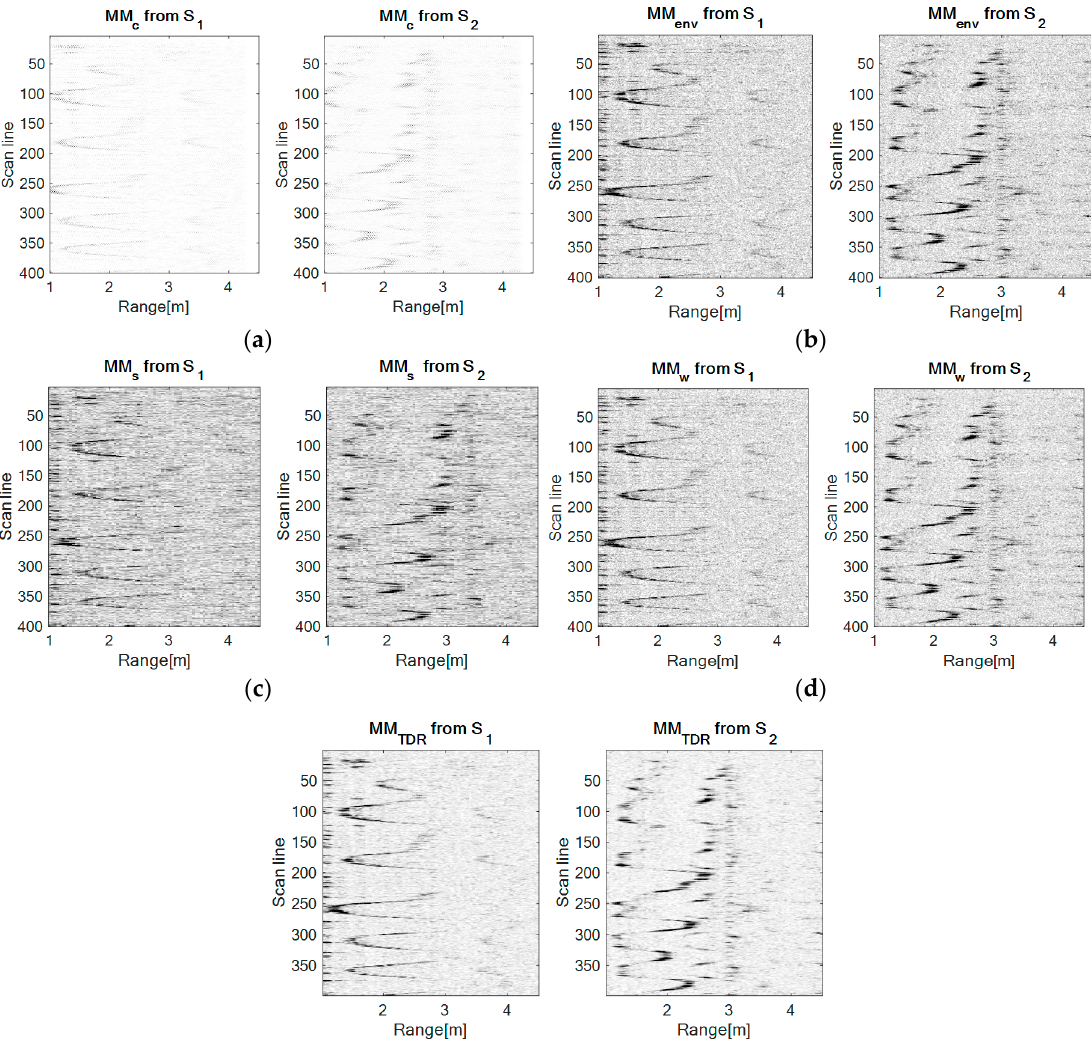
Figure 7. The movement maps for the forward-back configuration obtained with each method: ( a ) The correlation method, ( b ) the envelope detection method, ( c ) the spectrogram method: Window size: 64, number of overlapped samples: 60, number of FFT (Fast Fourier Transform) points: 128, ( d ) the wavelet transform method: Mother Morlet wavelet, ( e ) the time-distributed recurrence (TDR) RPA method: m = 5, d = 1.